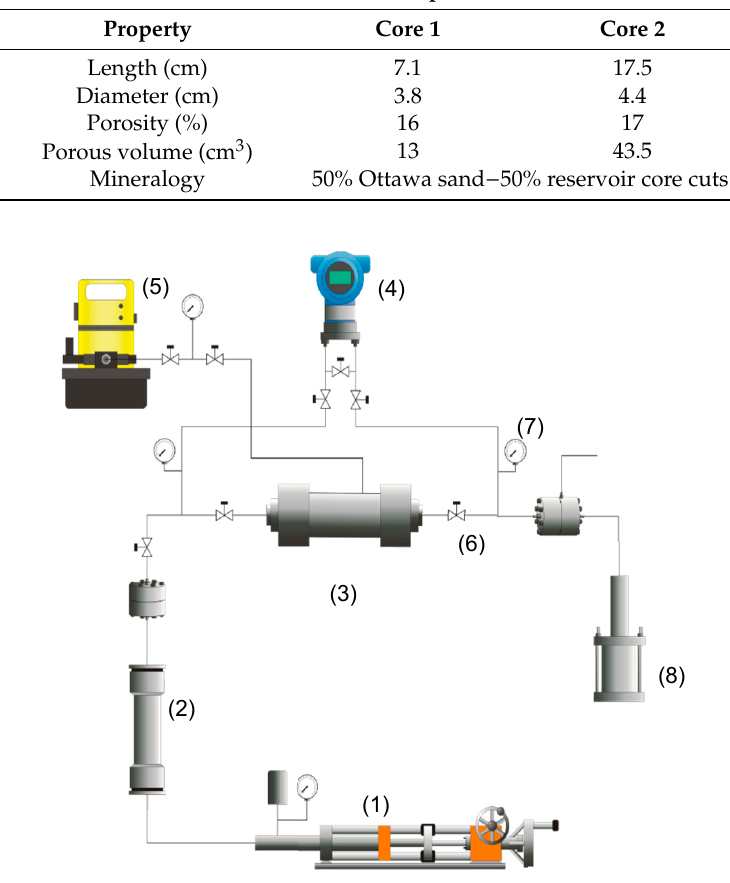
Figure 2. Schematic representation of the experimental setup for the displacement tests: ( 1 ) displacement pump, ( 2 ) cylinder, ( 3 ) sample core holder, ( 4 ) pressure transducer, ( 5 ) hydraulic pump, ( 6 ) valves, ( 7 ) manometers, and ( 8 ) a pressure multiplier.